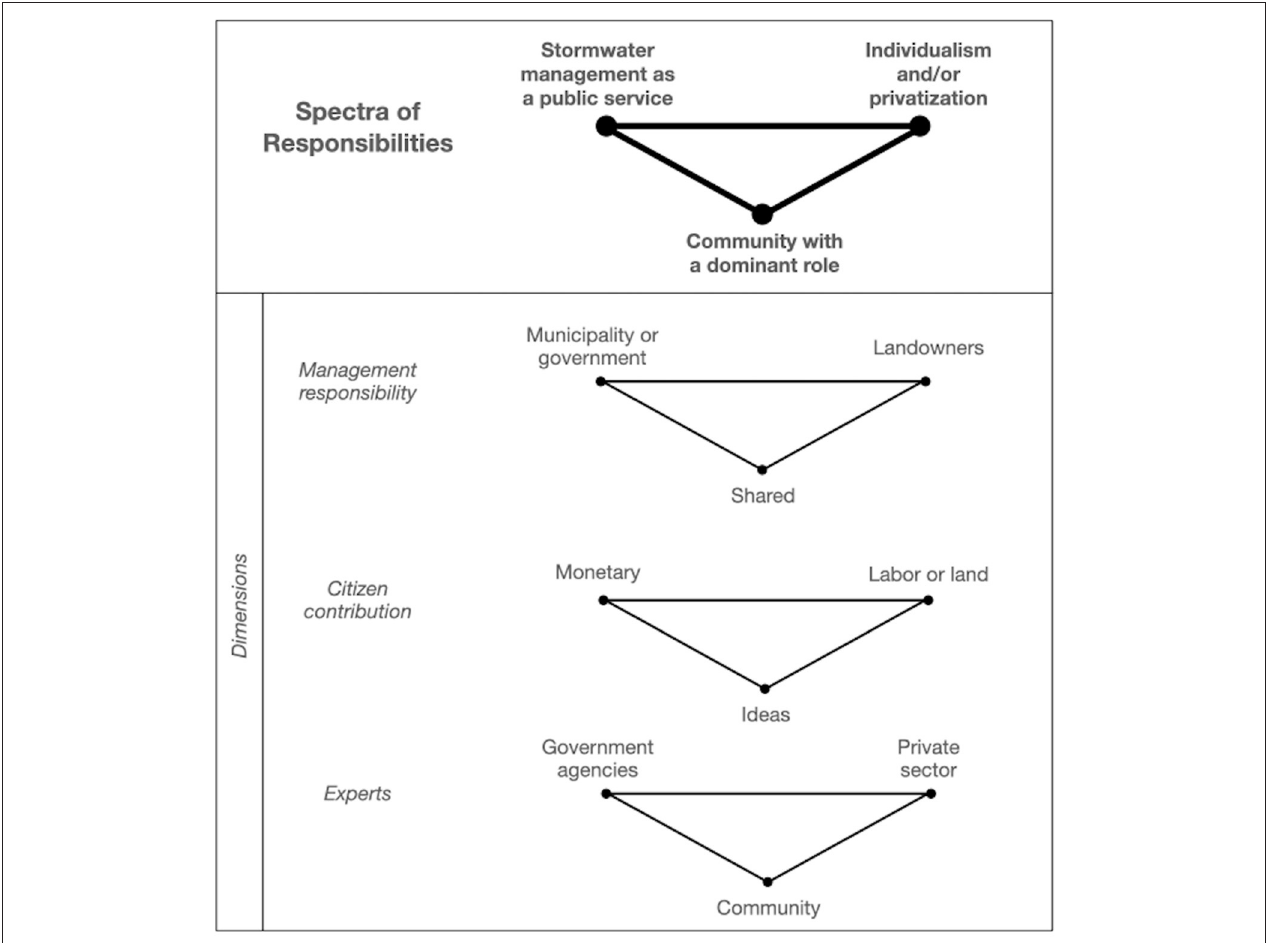
FIGURE 3 | A framework to understand aspects of responsibilities over stormwater